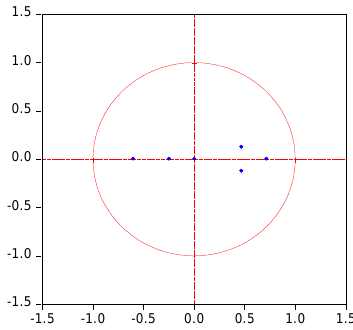
Figure 4. AR roots graph of the VAR model.